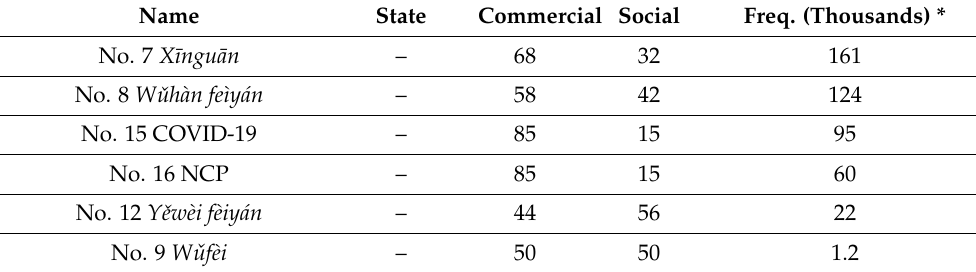
Table 4. Frequency and percentage distribution of six terms shared by commercial companies and social media; coronavirus disease name survey 2020. Name State Commercial Social Freq. (Thousands) * No. 7 X¯ıngu¯an – 68 32